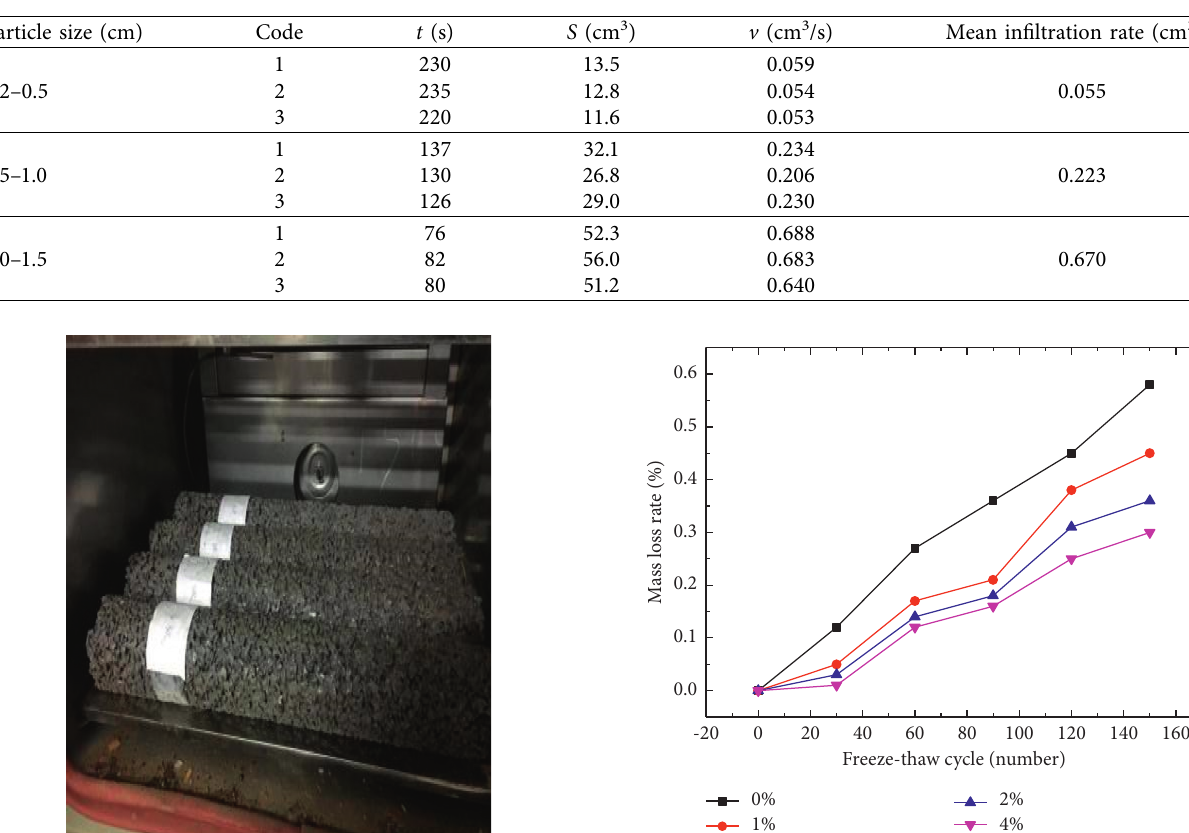
Figure 3: L-shaped infiltration apparatus. Table 4: Infiltration